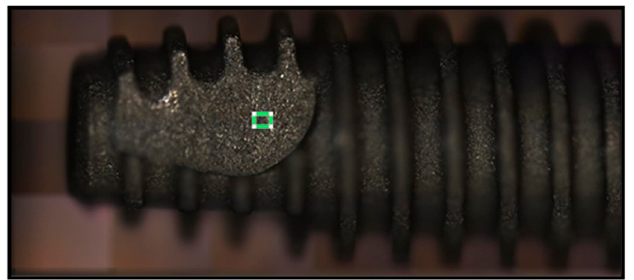
Figure 2. Selected zone for roughness measurement at the apical third of the implant.